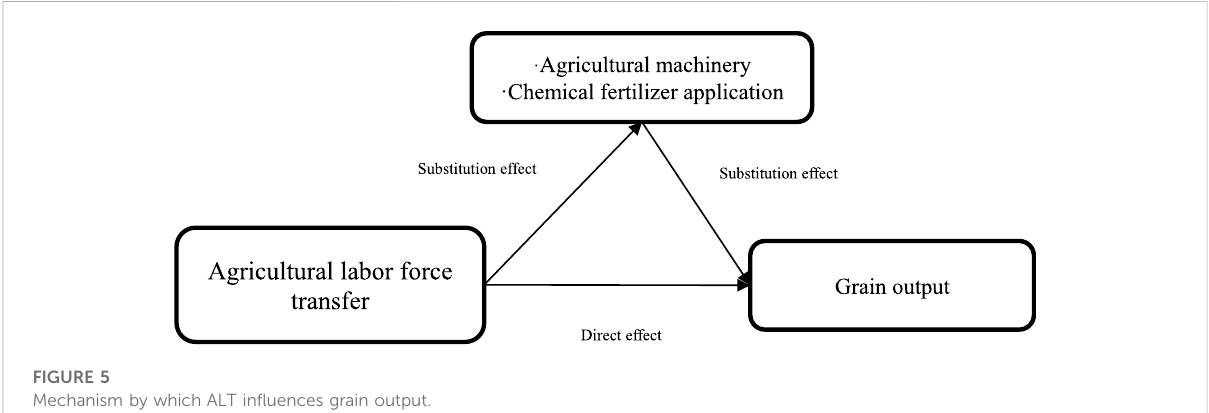
FIGURE 5 Mechanism by which ALT in fl uences grain